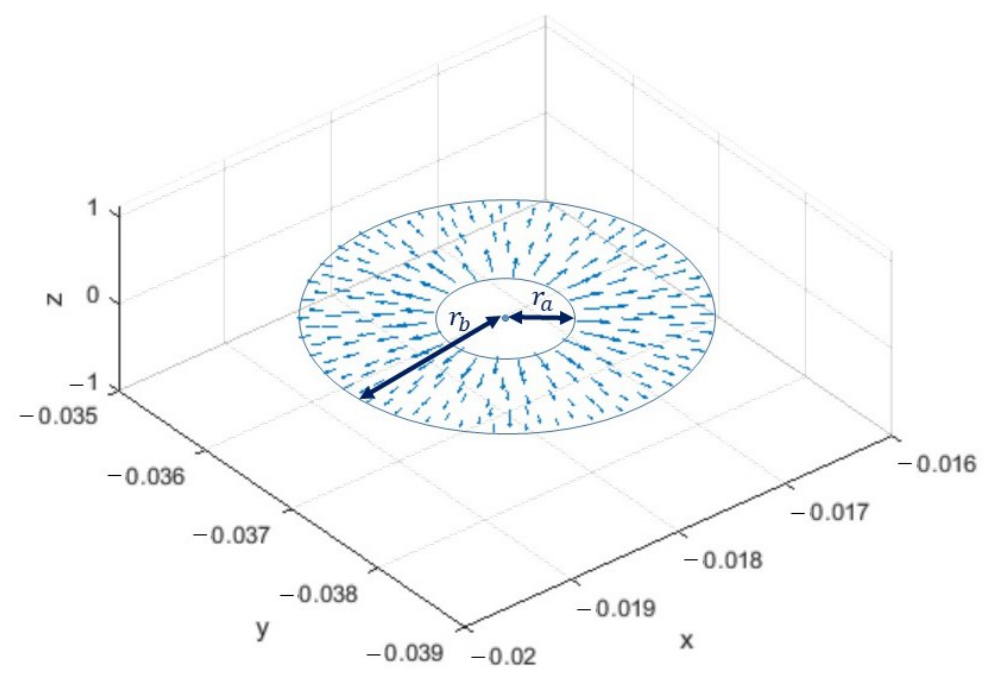
Figure 3. TEM mode on the coaxial port